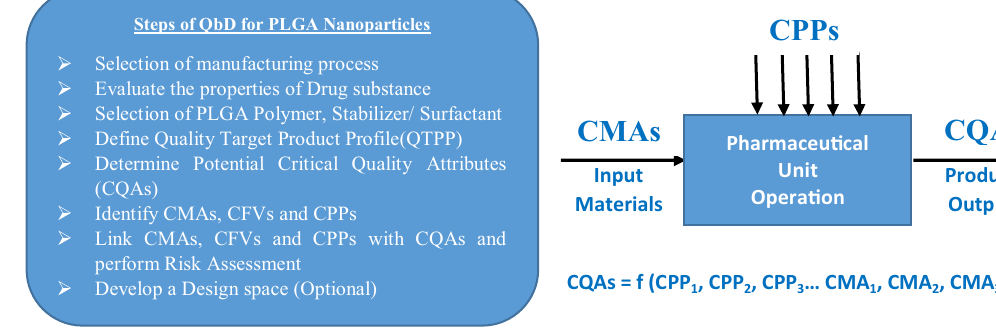
Fig. 1 Steps of QbD for PLGA based nanoparticles and QbD based relationship between CMA, CPPs, and CQAs